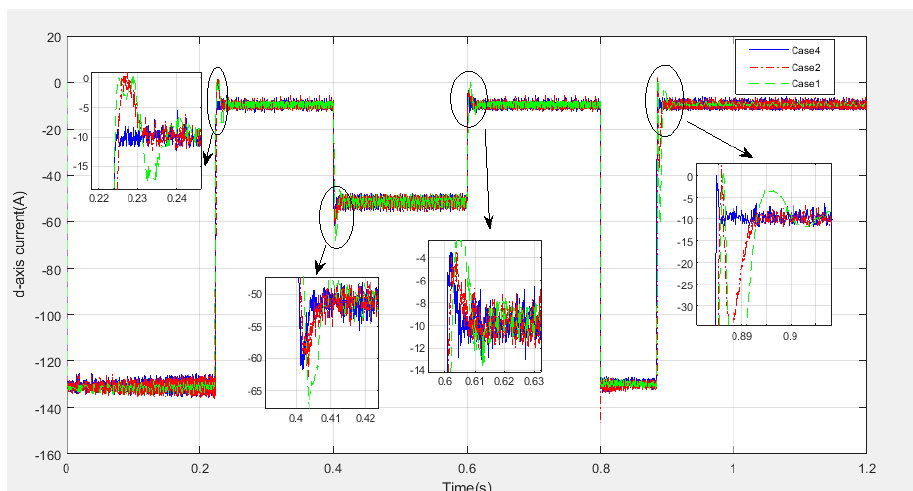
Figure 6. The d-axis current response in Case 1, Case 2 and Case 4.